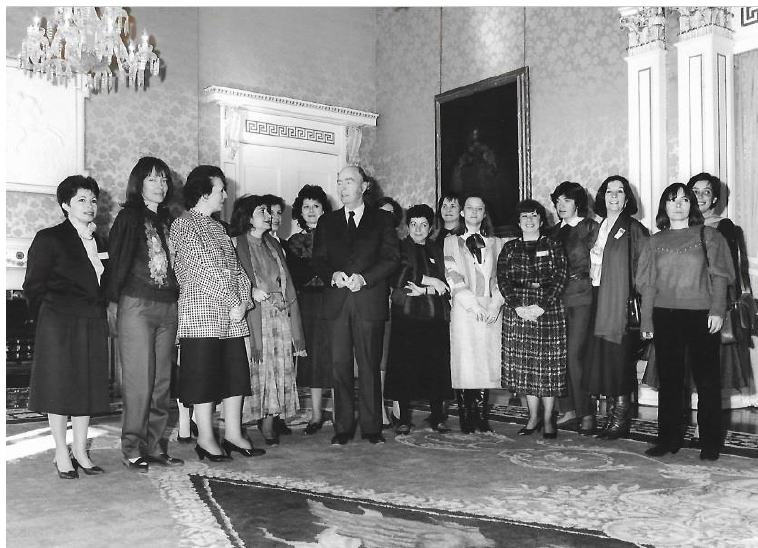
Figure 5. Participants in the “operation Bienvenida” project, promoted by the European Economic Community. Image used with